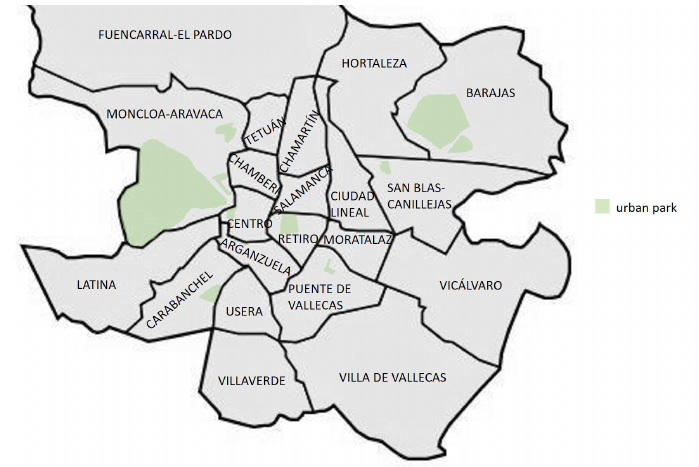
Figure 1. Map of Madrid with the studied green areas.